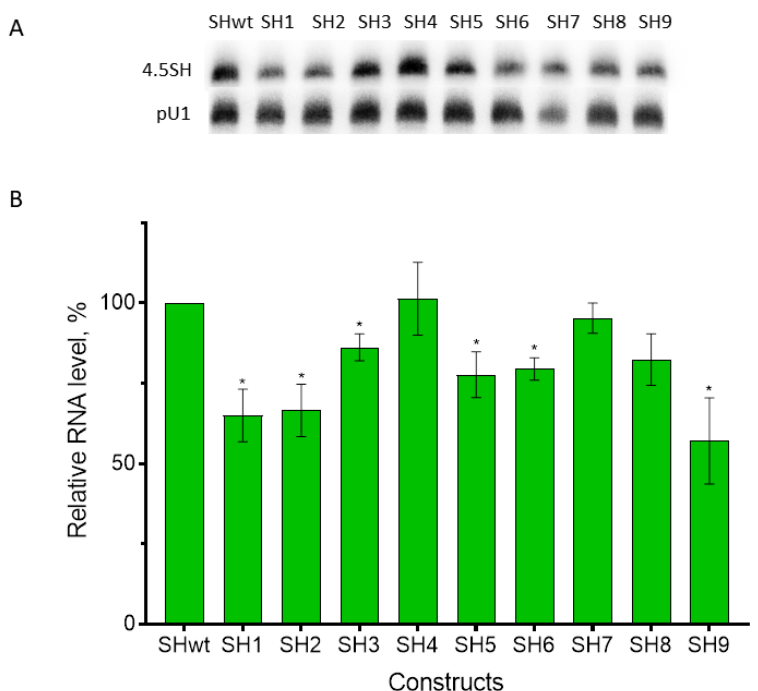
Figure 3. Nucleotide sequences of boxes A and B of 4.5SH and 4.5SI RNA genes, as well as B1 and B2 SINEs. The consensus sequences of boxes A and B of tRNA genes and SINEs [7,9] are shown above, and the nucleotide numbers are shown below. The nucleotides not matching the consensus boxes are highlighted in blue.